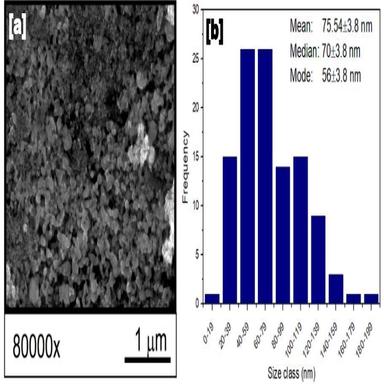
(a) SEM image (magnification 80000x) and (b) size distribution histogram for nZVSI